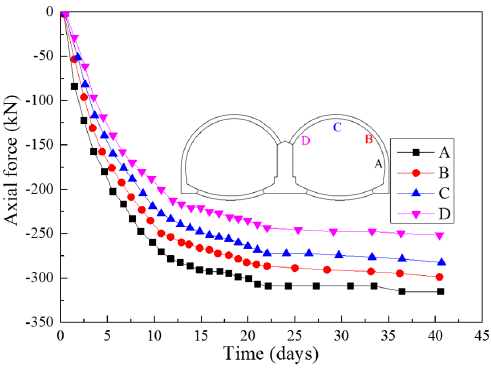
Figure 20. Time history plots of the axial forces in steel arches in the K89+729 section.